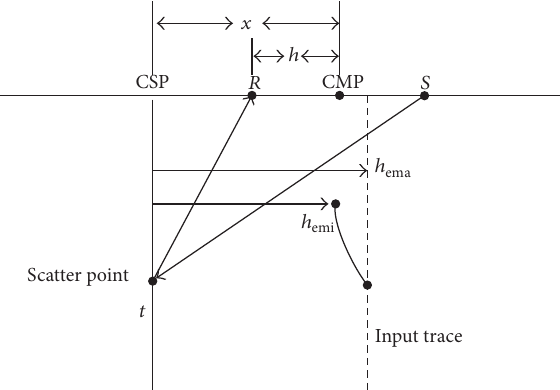
Figure 4: The mapping of the input trace to the CSP gather. The minimum equivalent offset ℎ ℎ are shown. ema